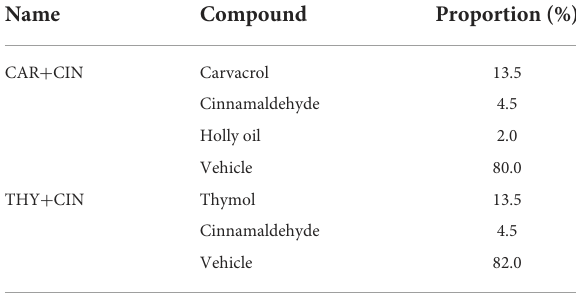
TABLE 2 Ingredients and nutrient composition of the basal diet